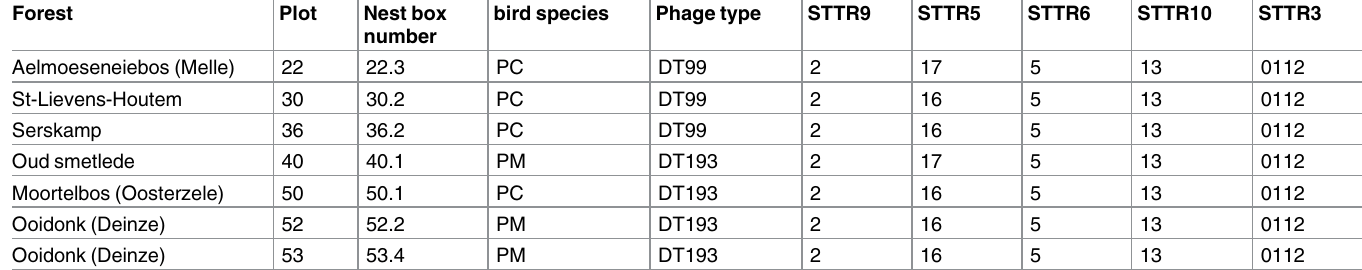
Table 5. Phage and MLVA typing of Salmonella Typhimurium. Shownare the phage types and MLVA profiles of the seven Salmonella Typhimurium iso- lates targeting 5 loci. Forest Plot Nest box number